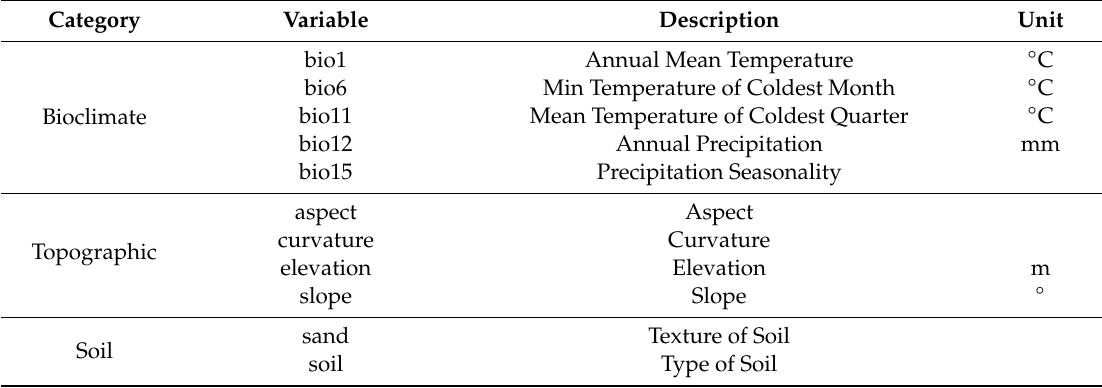
Table 1. Environmental variables used in predicting the potential distribution of Valsa mali